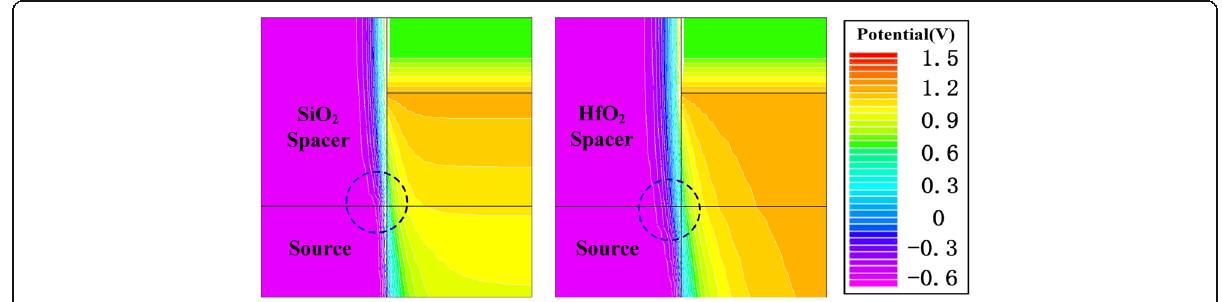
Fig. 5 Potential contours of the S/S/S (left) and H/S/S (right) after reading “ 1 ”